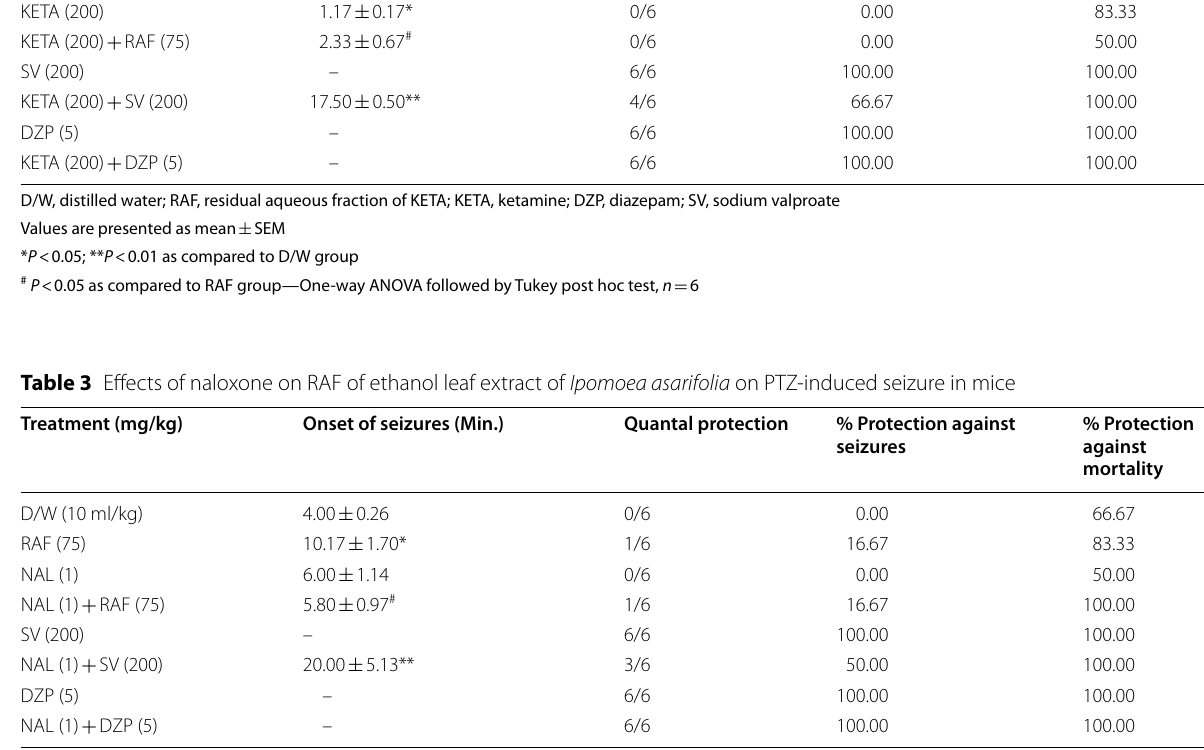
D/W, distilled water; RAFI, residual aqueous fraction of Ipomoea asarifolia ; NAL, naloxone; DZP, diazepam; SV, sodium valproate Values are presented as mean SEM ± * P < 0.05; ** P < 0.01 as compared to D/W group # P < 0.05 as compared to RAF group—One-way ANOVA followed by Tukey post hoc test, n